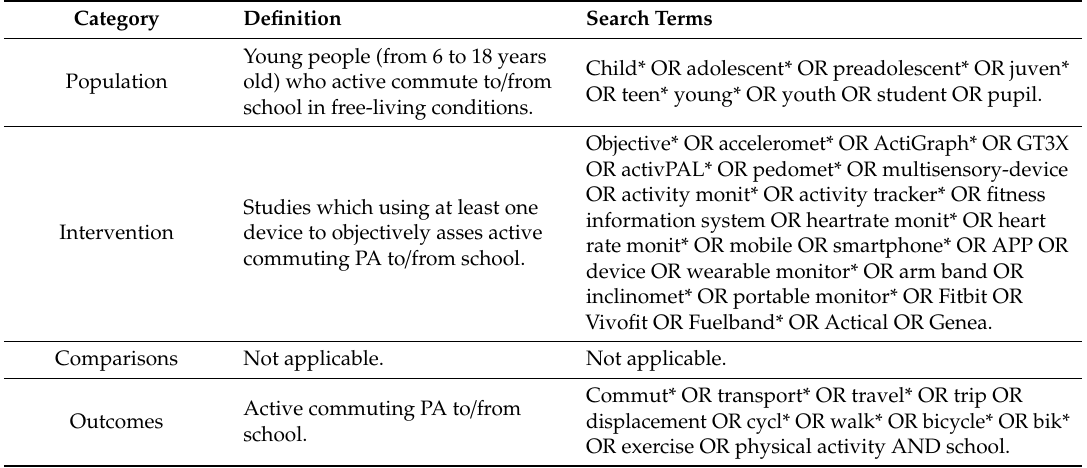
Table 1. PICO strategy: category, definition, and search